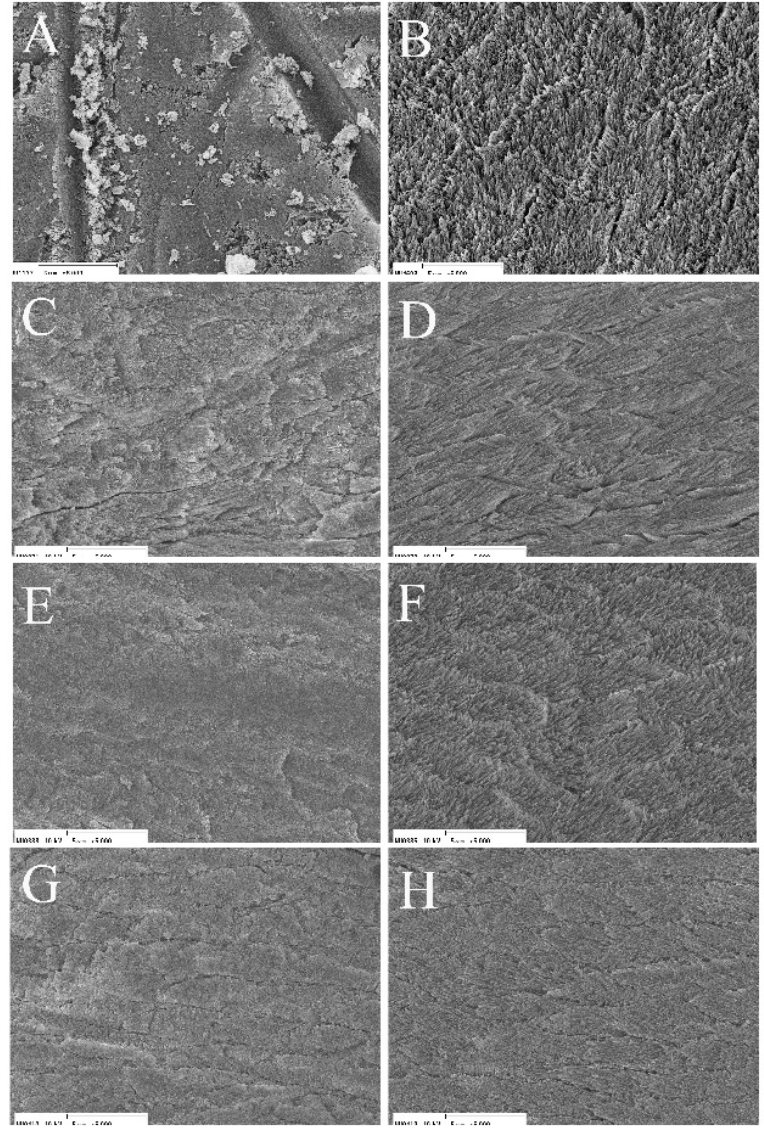
Figure 6. Representative SEM images of the treated enamel surface. ( A ) Ground with SiC paper #320 (×5000). ( B ) Phosphoric acid etching for 15 s (×5000). ( C ) CS in SE mode (×5000). ( D ) CS in ER mode (×5000). ( E ) GU in SE mode (×5000). ( F ) GU in ER mode (×5000). ( G ) OX in SE mode (×5000). ( H ) OX in ER mode (×5000).